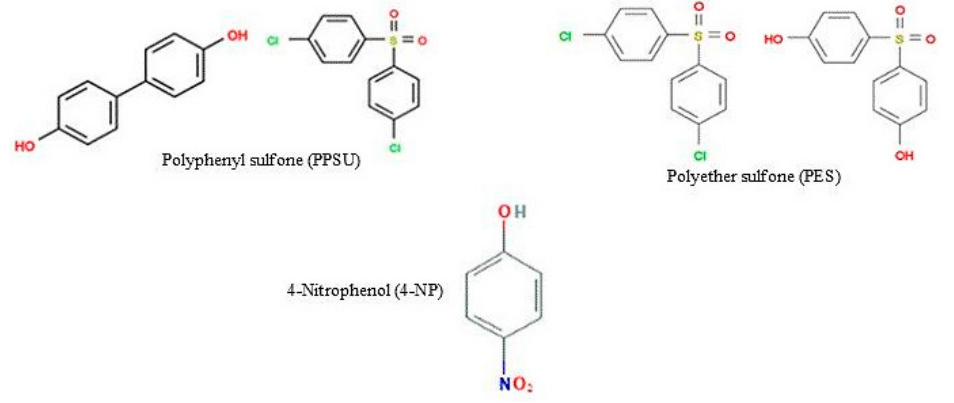
Figure 1. Chemical structures of PPSU, PES and 4 ‐ NP.